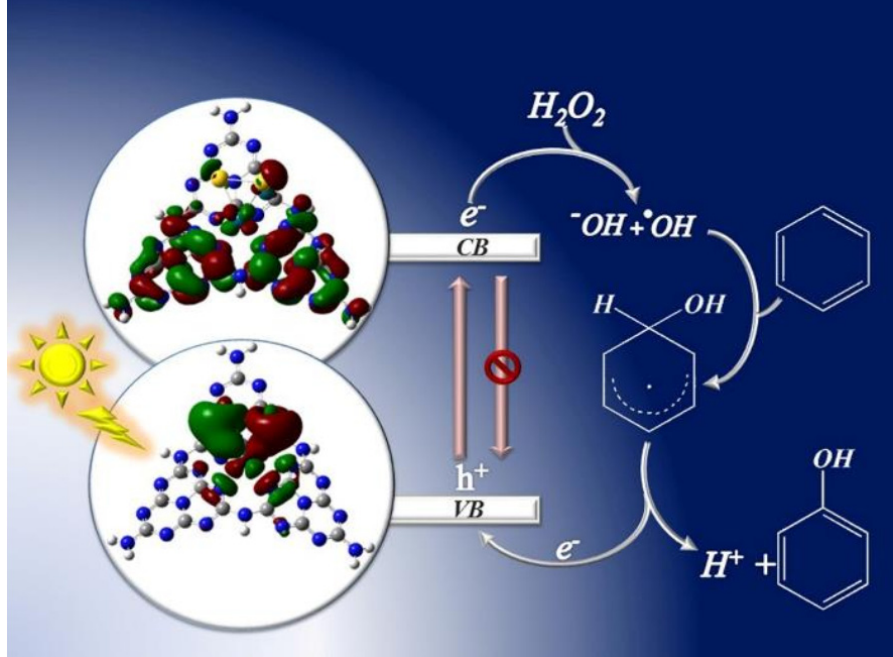
Figure 4. Proposed mechanism for hydroxylation of benzene by Au--Pd/g--C 3 N 4 catalyst under visible-light irradiation. Reprinted with permission from ref. [77] . 2018 American Chemical Society.